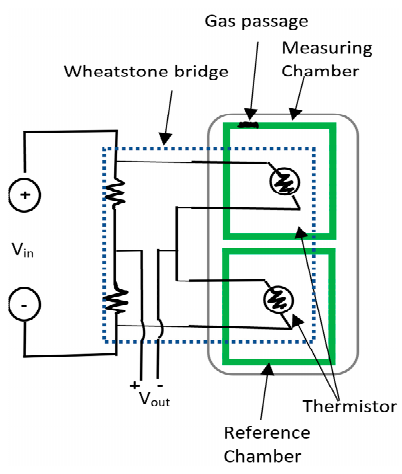
Figure 13. Structure of CO 2 sensor in a Wheatstone bridge configuration.